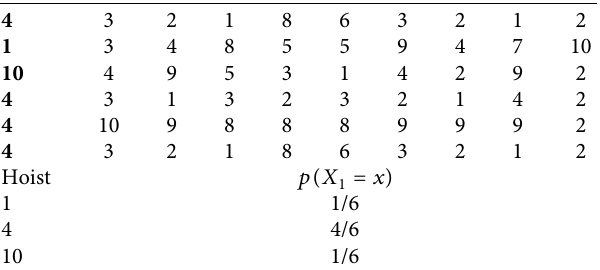
Table 6: Selected machine assignment vectors.